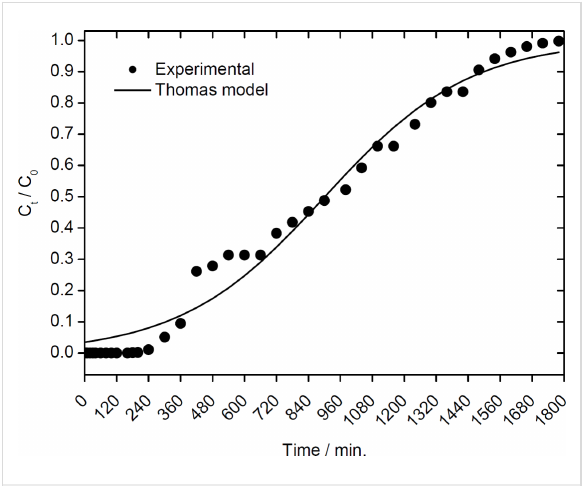
Figure 8: Experimental breakthrough curve for the adsorption of 4-nitrophenol onto 2Z-HYCA@650 °C ( C o = Concentration of 4-nitro- phenol at time 0; C t = Concentration of 4-nitrophenol at time t ).